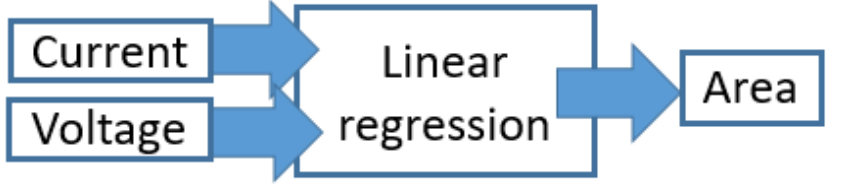
Figure 7. The configuration of the ECM model.